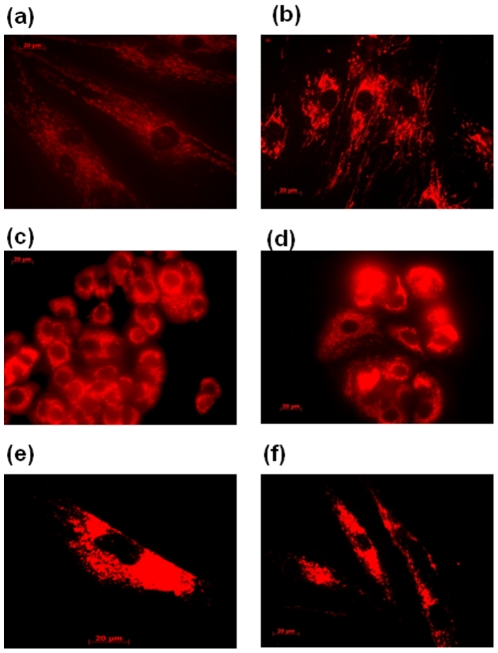
Fluorescence microscopy images of [30]phen2N6 (10 nM) in (a) NHDF, 5 min, (b) NHDF, 48 h, (c) MCF-7, 5 min, (d) MCF-7, 48 h, (e) P14, 5 min and (f) P14, 48 h; (1×104 cells/dish).